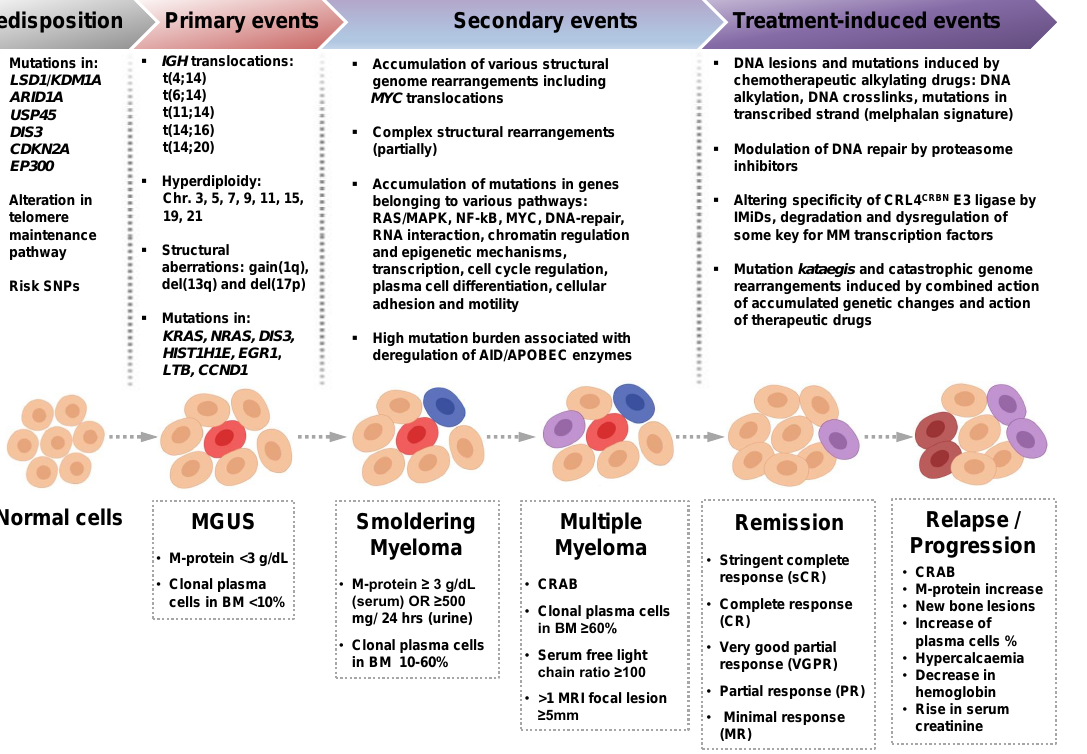
Figure 1. Stages of MM development and their characteristics. MM is almost always preceded by a precancerous condition termed monoclonal gammopathy of undetermined significance, MGUS [5–7]. Smoldering multiple myeloma (SMM) is an intermediate stage between MGUS and MM [12,13]. MGUS is diagnosed when serum monoclonal protein (M-protein) is detected, but levels are lower than in MM; a 2–3-fold elevation of the number of clonal bone marrow plasma cells is usually found in MGUS compared to healthy individuals. In MGUS, end-organ damage, CRAB, attributed to the plasma cell proliferative disorder, is absent [1]. SMM is diagnosed when serum or urinary monoclonal protein rises and/or the number of clonal bone marrow plasma cells increases, but there is no MDE or amyloidosis [1]. There are germline risk alleles in several genes associated with familiar cases of MM and MGUS; also, numerous SNPs found in GWAS are associated with MM development risk. Telomere status is another factor that can affect MM development. Primary events can be found as early as MGUS and are represented by structural genome changes, gain of chromosomes, and mutations. The primary structural genomic changes are nearly equally represented by the two major groups: the IGH translocations and trisomies of several odd chromosomes (referred to as hyperdiploidy). Few other structural aberrations found as early as the MGUS stage are listed. While the disease progresses, more genomic changes accumulate. The events that are characteristic of SMM and MM, but not MGUS, are classified as secondary. They are represented by various structural genome changes including MYC translocations, accumulation of complex genome rearrangements (partially, since some of them can be seen at MGUS stage), mutations in various pathways, and AID/APOBEC-induced mutation burden. The endpoint of the scheme illustrates treatment-induced events. Some of them can modulate DNA repair and impact genome stability and mutation accumulation. Abbreviations: IMiDs—Immunomodulatory drugs; CRAB—an acronym for Calcium (elevated), Renal failure, Anemia, and Bone lesions, the most common symptoms of MM; MDE—myeloma-defining events (see text for more details); MRI—magnetic resonance imaging; BM—bone marrow; AID—activation-induced cytosine deaminase essential for class switch recombination (CSR) and somatic hypermutation (SHM); APOBEC—a family of cytosine deaminases that play an essential role in mutagenesis in cancer cells; GWAS—Genome-Wide Association